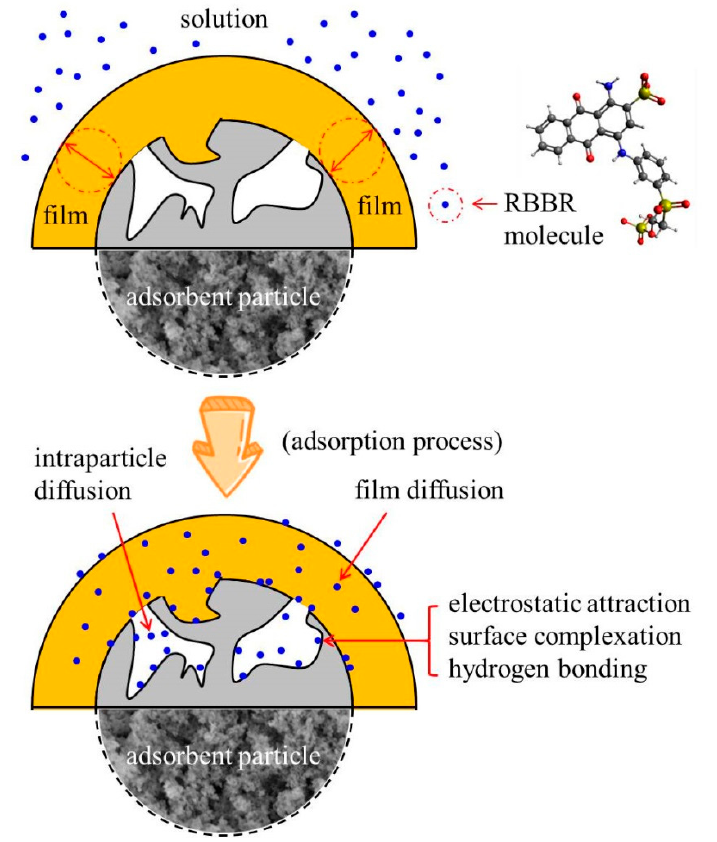
Figure 8. Possible mechanisms for RBBR adsorption retained by UPA( θ )